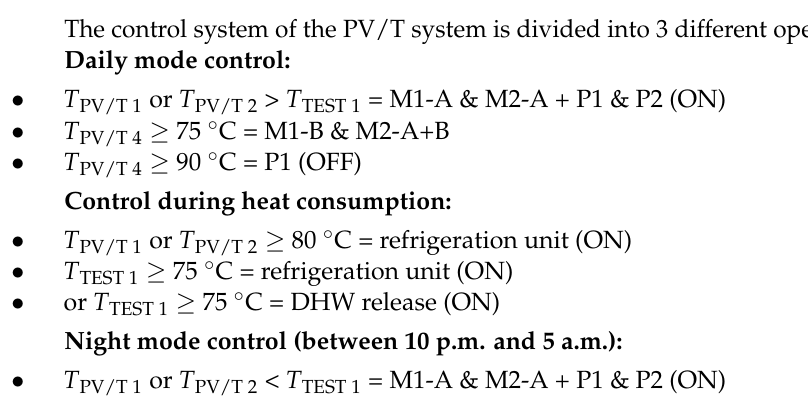
Figure 2. PV/T system: ( 1 ) PV/T modules, ( 2 ) heat exchangers, ( 3 ) refrigeration unit, ( 4 ) TEST, ( 5 ) pyranometer, and ( 6 ) anemometer and ambient temperature sensor. The control system of the PV/T system is divided into 3 different operational